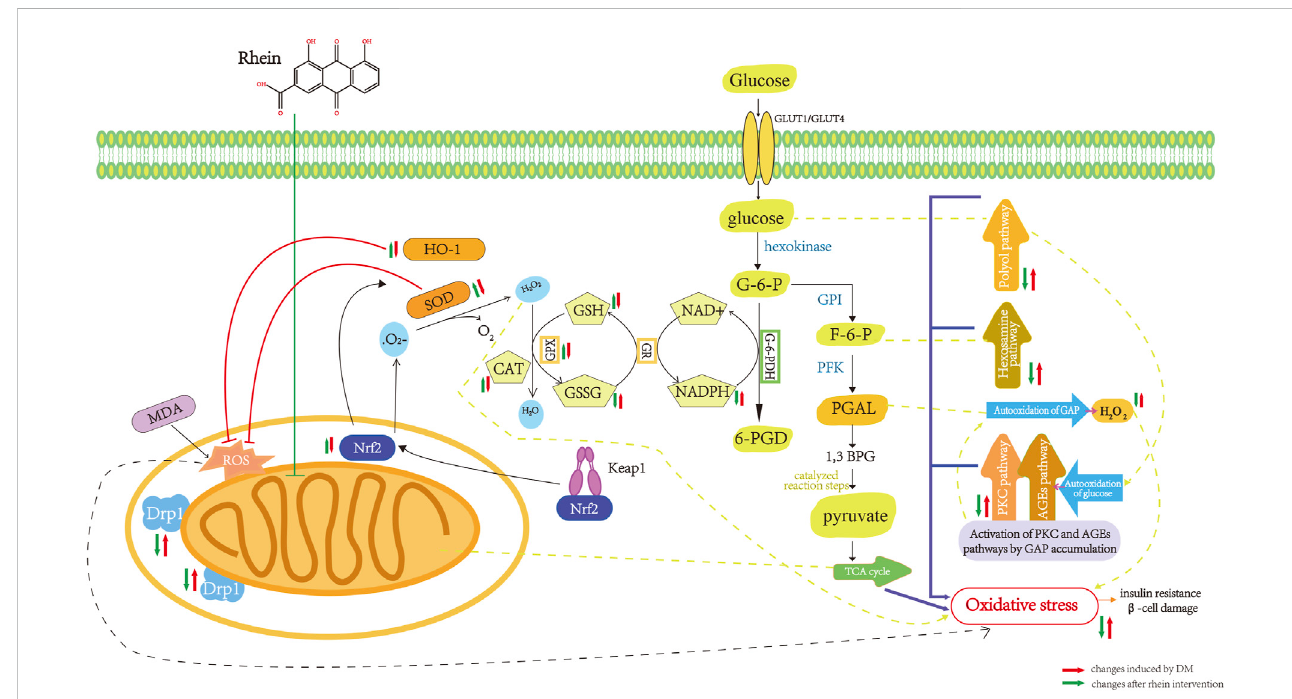
FIGURE 4 Pharmacological mechanism of rhein in inhibition of oxidative stress in diabetes mellitus. Drpl, dynamin-relatedprotein 1; Nrf2, nuclea factor erythroid- 2-related factor 2; MDA,malonaldehyde; ROS, reactive oxygen species; SOD,superoxide dismutase; HO-1, Heme Oxygenase-1; CAT,catalase; GPX, glutathione peroxidase; GSH, glutathione,reduced; GSSG glutathione,oxydized; GR, gluathione reductase; NADPH, nicotinamide adenine dinucleotide phosphate; G-6-PDH,glucose-6-phosphate dehydrogenase; G-6-P, glucose-6-phosphate; GPI, phosphohexose isomerase; F-6-P, fructose-6- phosphate; PEK, Phosphofructokinase; PGAL, glyceraldehyde-3-phosphate; 1,3 BPG, 1,3 Biphosphoglycerate; TCA cycle,